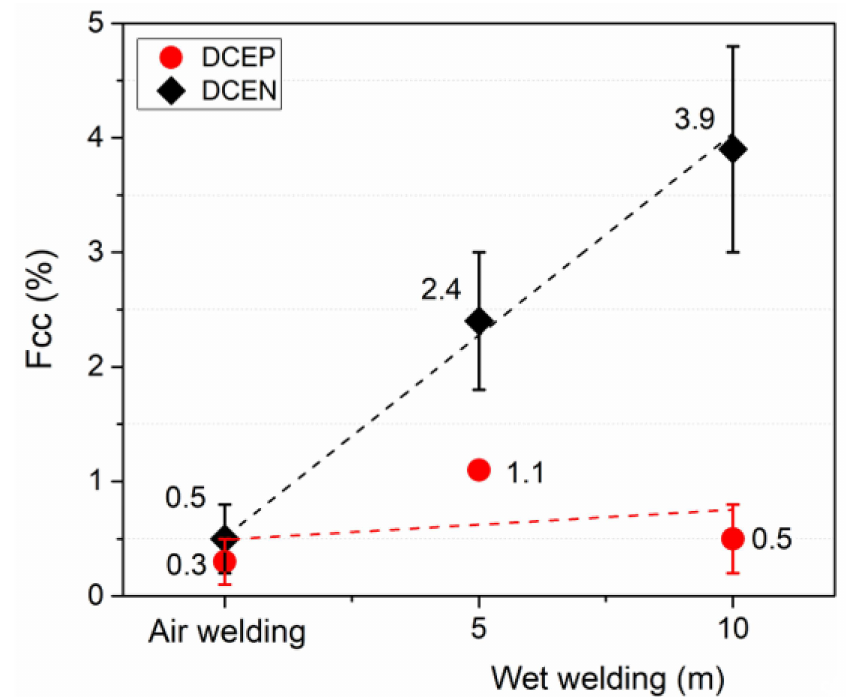
Figure 8. Fcc for rutile electrode in both polarities and for all conditions. Error bars show the standard